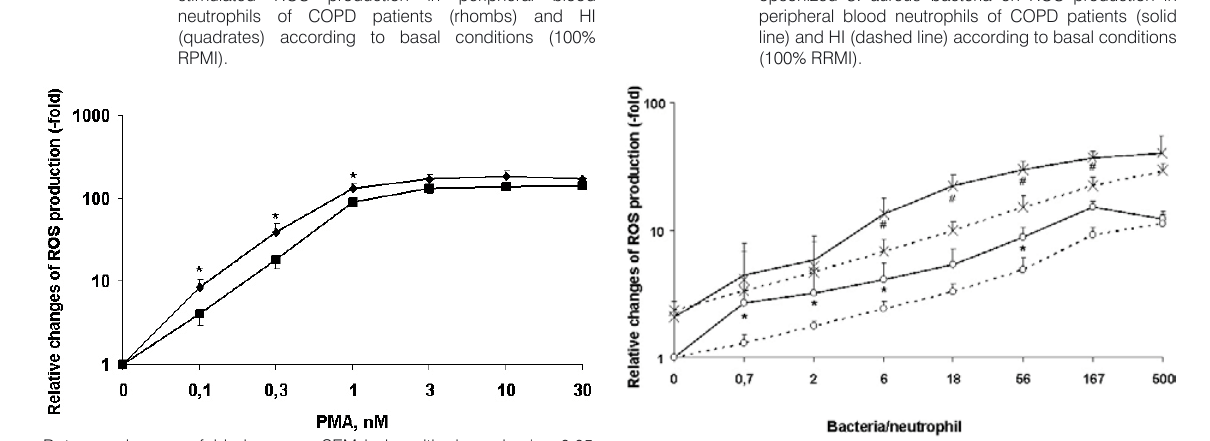
compared to HI between non-opsonized bacteria, #p<0.05 compared to HI between opsonized bacteria.